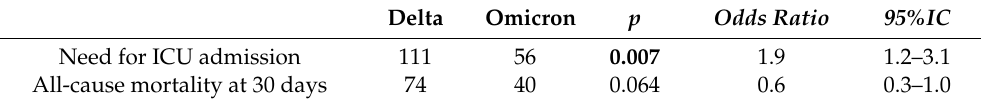
Table 5. Multiple logistic regression analysis to evaluate differences in outcomes (need for ICU and death at 30 days) based on different variants (Delta or Omicron) after correction for age, sex, number of comorbidities, main chronic diseases, vaccine status, and treatment. (Significant p values are in